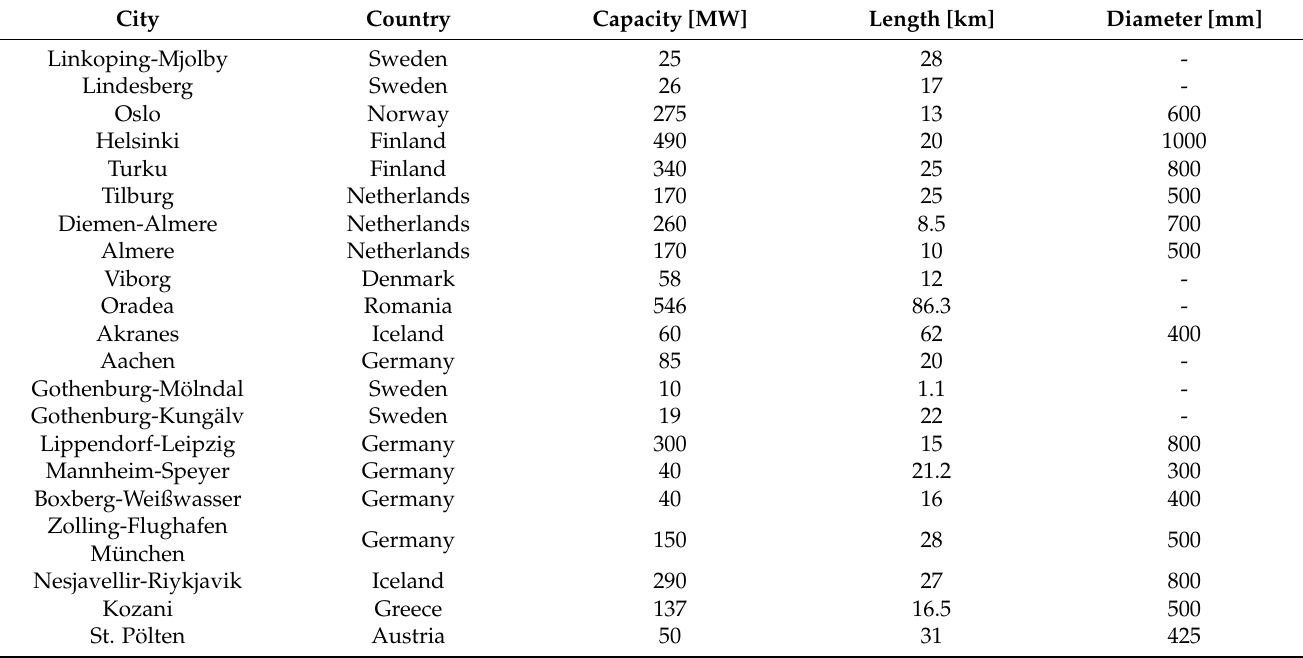
Table 1. District heating transmission pipelines in Europe